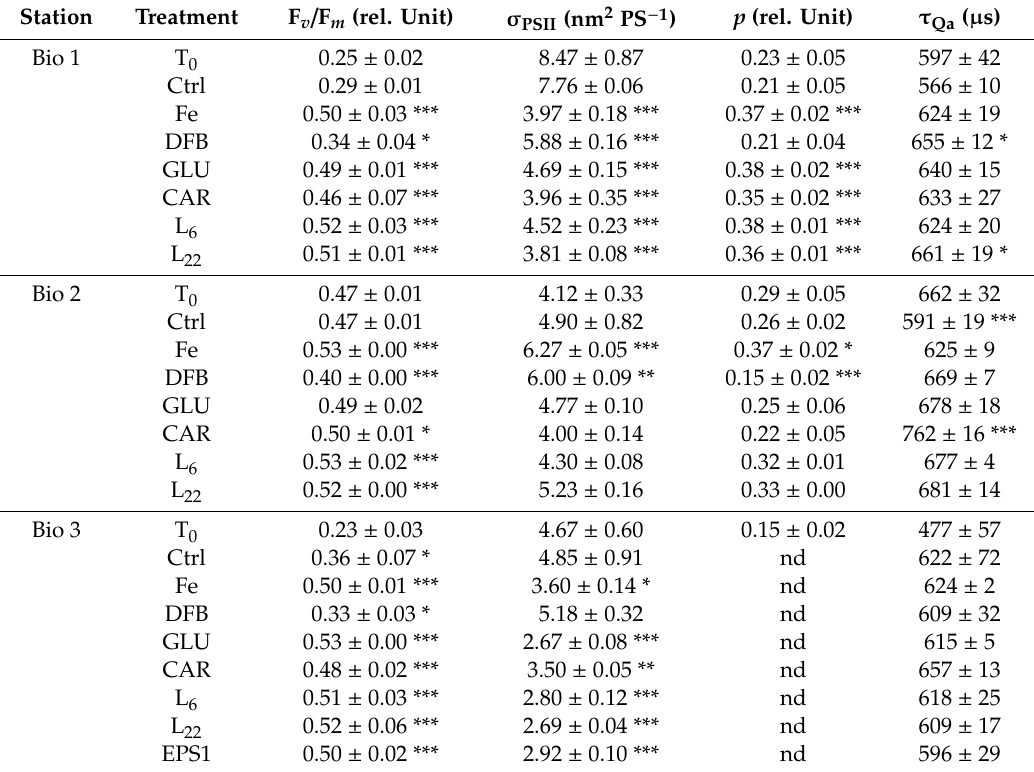
The photophysiological parameters maximum photochemical e ffi ciency (F v / F m ), functional absorption cross section of photosystem II ( σ PSII ), connectivity between PSII (P), andre-oxidationtimeoftheprimaryelectronacceptorQ a ( τ Qa )determinedforthreenaturalcommunities from the Drake Passage (Bio 1 and Bio 3) and the West Antarctica Peninsula (Bio 2) measured at the day of sampling (T 0 ) and after six days incubation in seawater (Ctrl = control, no Fe enrichment) and enriched with Fe (Fe = inorganic Fe addition, FeCl 3 ) bound to di ff erent organic ligands (DFB = desferrioxamine B, GLU = glucuronic acid, CAR = carrageenan, L 6 = bacterial